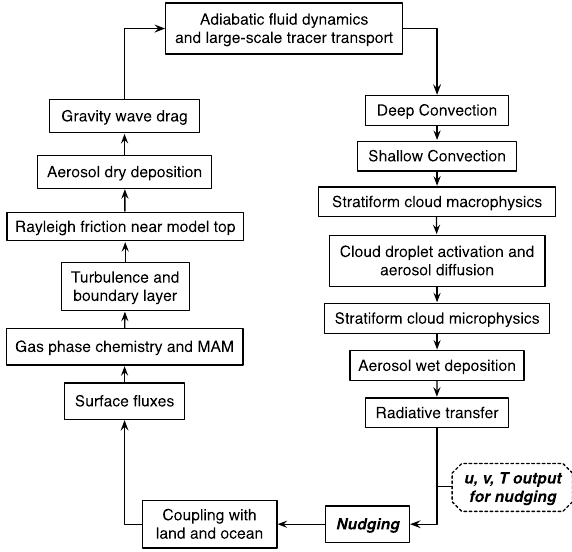
Figure 1. Flowchart showing the implementation of nudging in the computing sequence of the CAM5